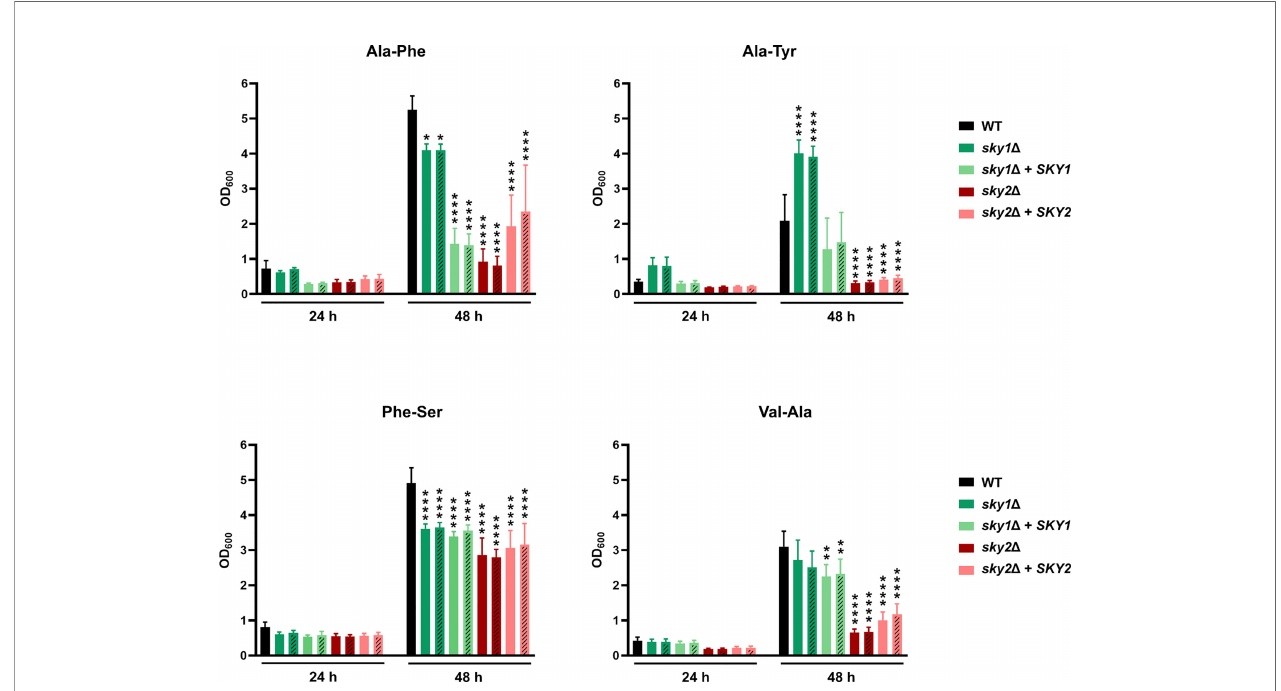
FIGURE 4 | CaSky2 is important for utilization of selected dipeptides as the sole nitrogen source. YPD overnight cultures were adjusted to an optical density (OD 600 ) of 0.01 in YCB medium containing 10 mM of the indicated dipeptide as a nitrogen source and incubated at 37°C. The OD 600 was measured after 24 h and 48 h. Both independently generated series of mutants are displayed. The B strains are represented by dashes in the bars. The values shown are the calculated mean and standard deviation of three biological replicates. Growth differences of mutant strains to the wild-type strain SC5314 were analyzed by two-way ANOVA followed by Dunnett ’ s test (*, p < 0.05; **, p < 0.01; ****, p <